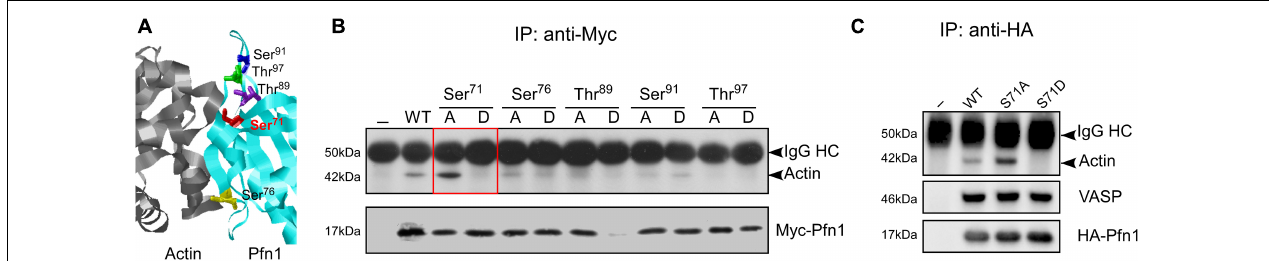
FIGURE 1 | Mimicking Ser 71 phosphorylation by the S71D mutation abolishes actin-binding of Pfn1. (A) X-ray diffraction structure of human Pfn1 (right, cyan) bound with actin (left, purple) (Protein Data Bank ID 2PAV) (Ferron et al., 2007). Ser 71 and four other serine and threonine residues in the actin-binding region of Pfn1 are displayed in the sticks mode. (B) HEK293T cells were transfected with Myc-tagged wild type or mutant Pfn1 containing alanine (A) or aspartate (D) substitutions on the five candidate serine or threonine residues. Lysates were subjected to immunoprecipitation using a Myc-tag antibody, and Western blot was used to detect Myc-Pfn1 and co-precipitated actin. (C) HEK293T cells were transfected with wild type or mutant forms of HA-tagged Pfn1 containing S71A or S71D, which were subsequently immunoprecipitated by an anti-HA tag antibody. Lysates were subjected to immunoprecipitation, and samples were blotted for actin, VASP, and HA-tag (to visualize